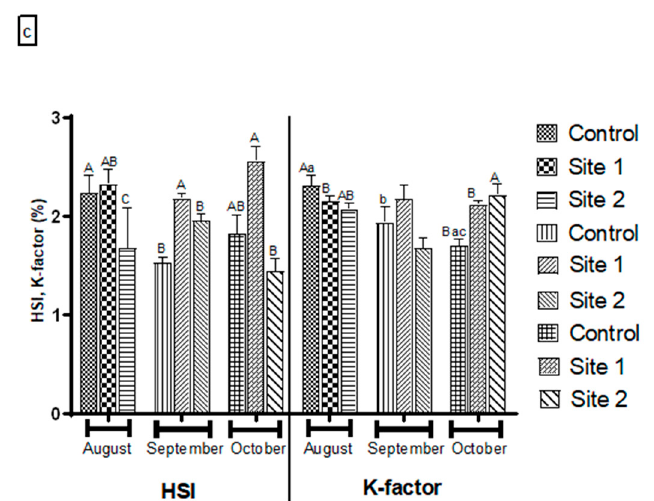
Figure 2. ( a ) Weight (Wt) and Length (L), ( b ) testicular somatic index (TSI), ( c ) hepatosomatic index (his), and K-factor of Nile tilapia collected from di ff erent sampling sites. Data are presented as the mean of 20 fish ± standard error of mean (SEM). Values with a di ff erent uppercase letter superscript indicate a significant di ff erence between sites at the same sampling time. Values with di ff erent lowercase letter superscript are significantly di ff erent between sampling time points within the same site ( p < 0.05, two-way